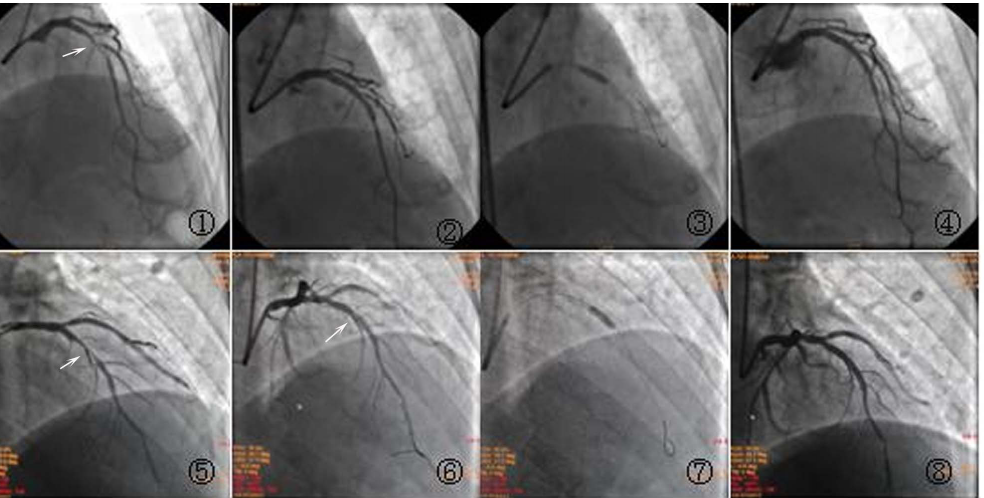
Figure 1. High-pressure post-dilation following coronary stent deployment. 1. Long lesions at the middle of LAD with 90% stenosis, the vessel diameter difference was significant between the proximal and distal segment. 2. Stent deployment in the LAD lesions. 3. Proximal stented segment was post-dilated with a non-compliant balloon. 4. Stent well-deployment after post-dilation,the proximal and distal segment morphology was even. 5. Tubular lesions at the middle of LAD with 90% stenosis,the vessel diameter difference was not significant between the proximal and distal segment. 6. Stent deployment in the LAD lesions and the middle of stent was incomplete apposition. 7. Middle stented segment was post- dilated with a non-compliant balloon. 8. Stent well-deployment after post-dilation,the proximal and distal segment morphology was even. doi:10.1371/journal.pone.0082357.g001 PLOS ONE |